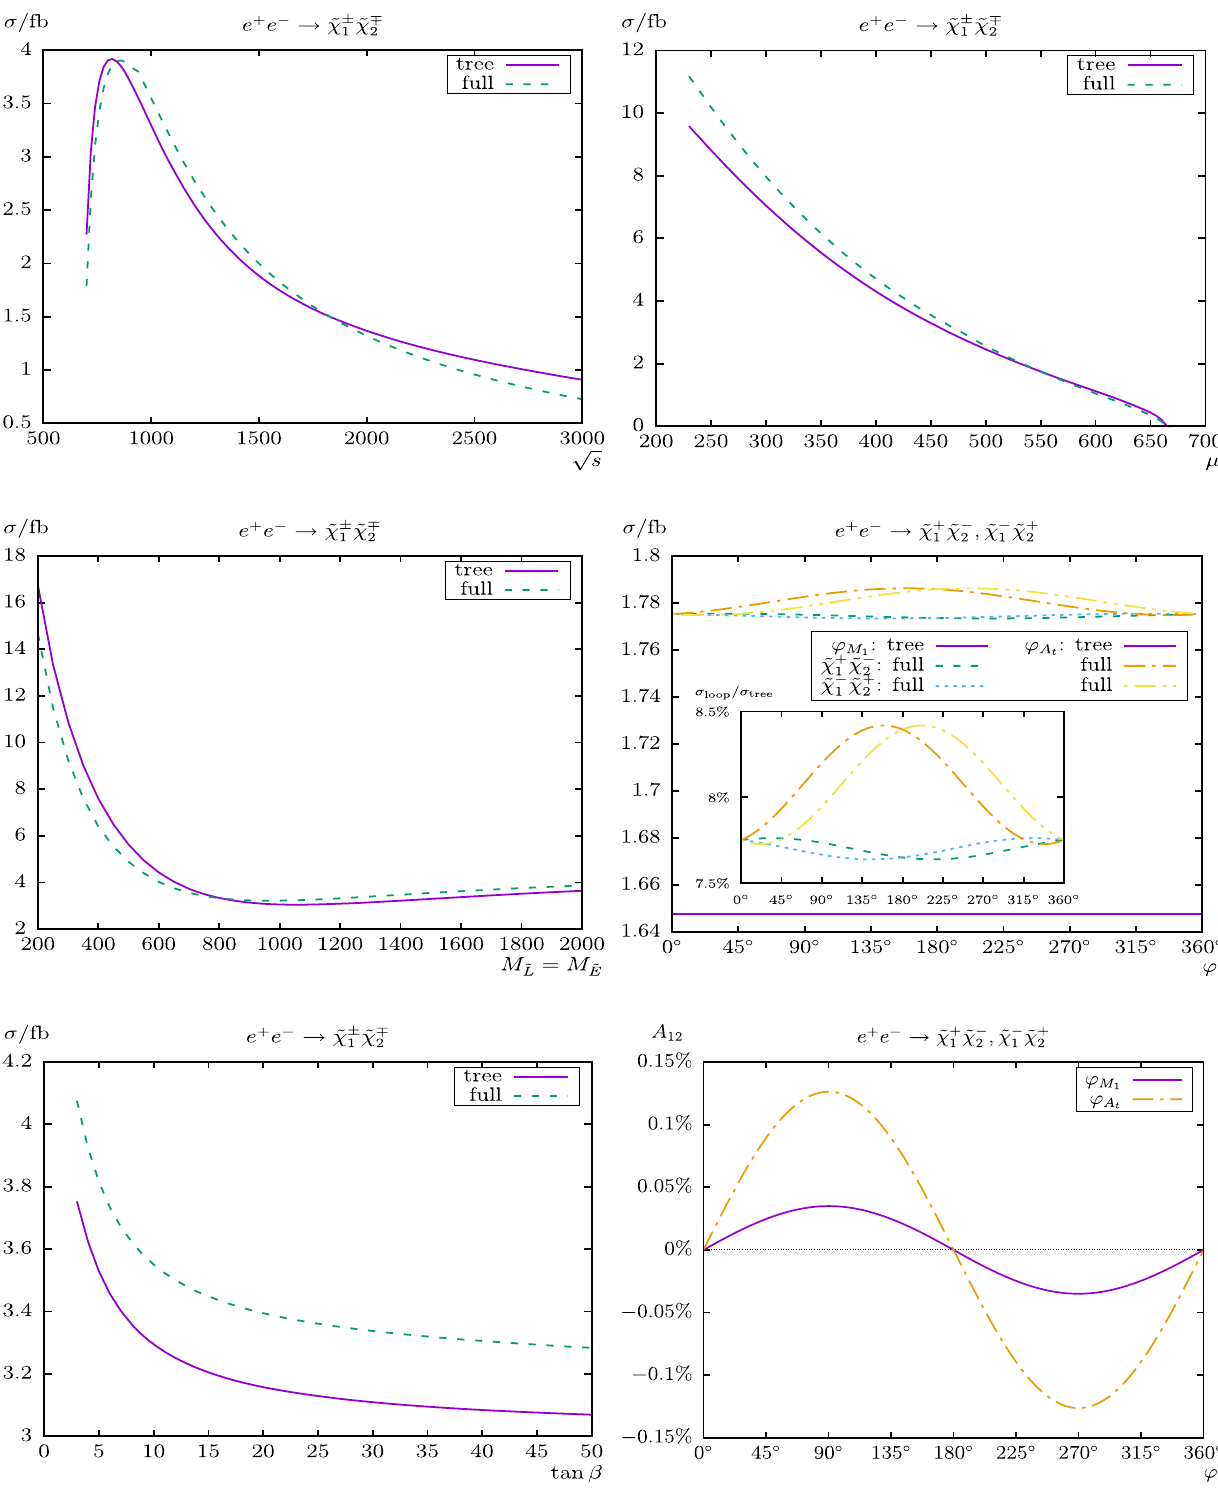
˜ χ ∓ ) . Tree-level and full one-loop corrected (right) varied; the lower plot the variation with t β (left) and the CP -odd 1 2 observable A 12 (right) varied with the complex phases ϕ M √ s (left) and μ All masses and energies are in = M ˜ ,ϕ (left) and ϕ M A t L E 1